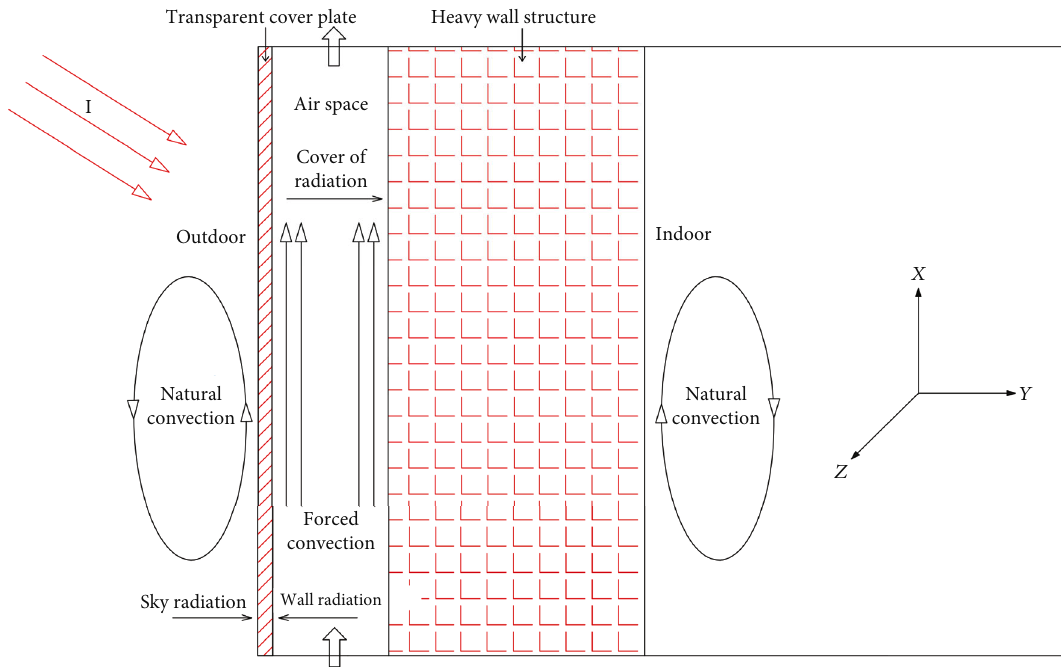
Figure 3: Schematic diagram of heat transfer and exchange process of heat storage